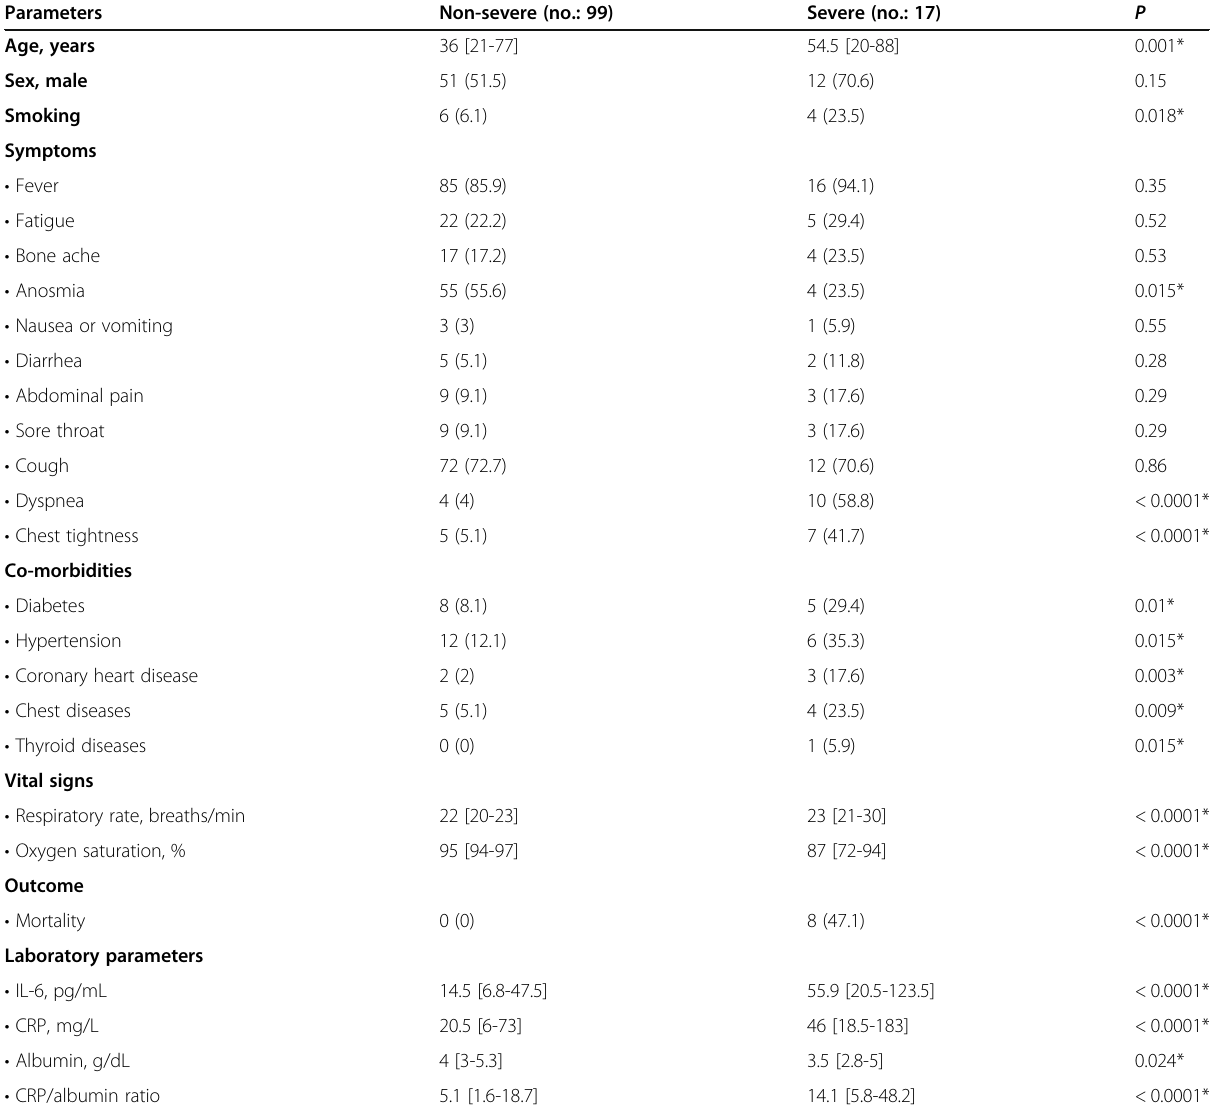
Table 1 Demographic, clinical, and laboratory characteristics of the patients Parameters